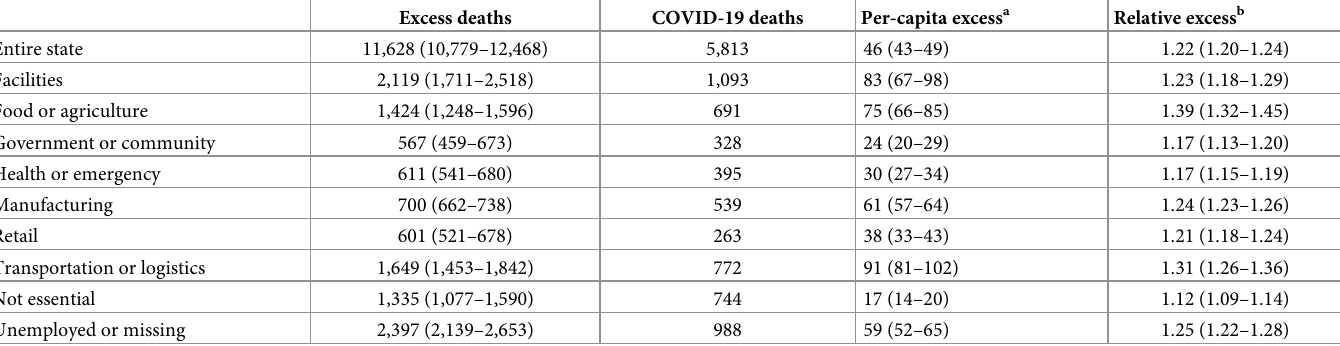
Table 1. Excess mortality among Californians 18–65 years of age, by occupational sector, March through November